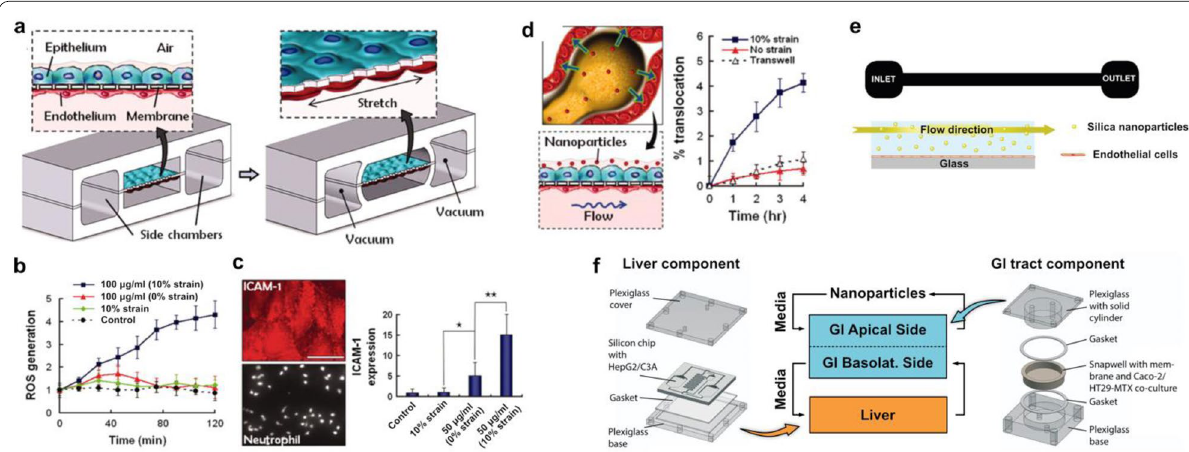
Fig. 6 Toxicity of nonmetal nanoparticles. a A human breathing lung-on-a-chip was created by culturing human alveolar epithelial cells and pulmonary microvascular endothelial cells on opposite sides of a porous membrane. Vacuum chambers allowed for physiological mechanical breathing stresses to be applied. b Introduction of silica nanoparticles in the presence of mechanical cues resulted in significant oxidative stress responses. c Mechanical strain also significantly increased the expression of ICAM-1 and neutrophil adhesion to the endothelial side of the device, Scale bar, 50 µm, d and increased the translocation of nanoparticles from the alveolar to vascular compartments. e A microfluidic device coated with endothelial cells was used to assess the toxicity of silica particles. Mechanical stimulation through shear stresses resulted in lower cell viabilities. f A liver and gastrointestinal system body-on-a-chip was created to study the liver injury potential of carboxylated polystyrene nanoparticles. Introduction of the nanoparticles to the apical side of the gastrointestinal (GI) component resulted in a dose-dependent increase in